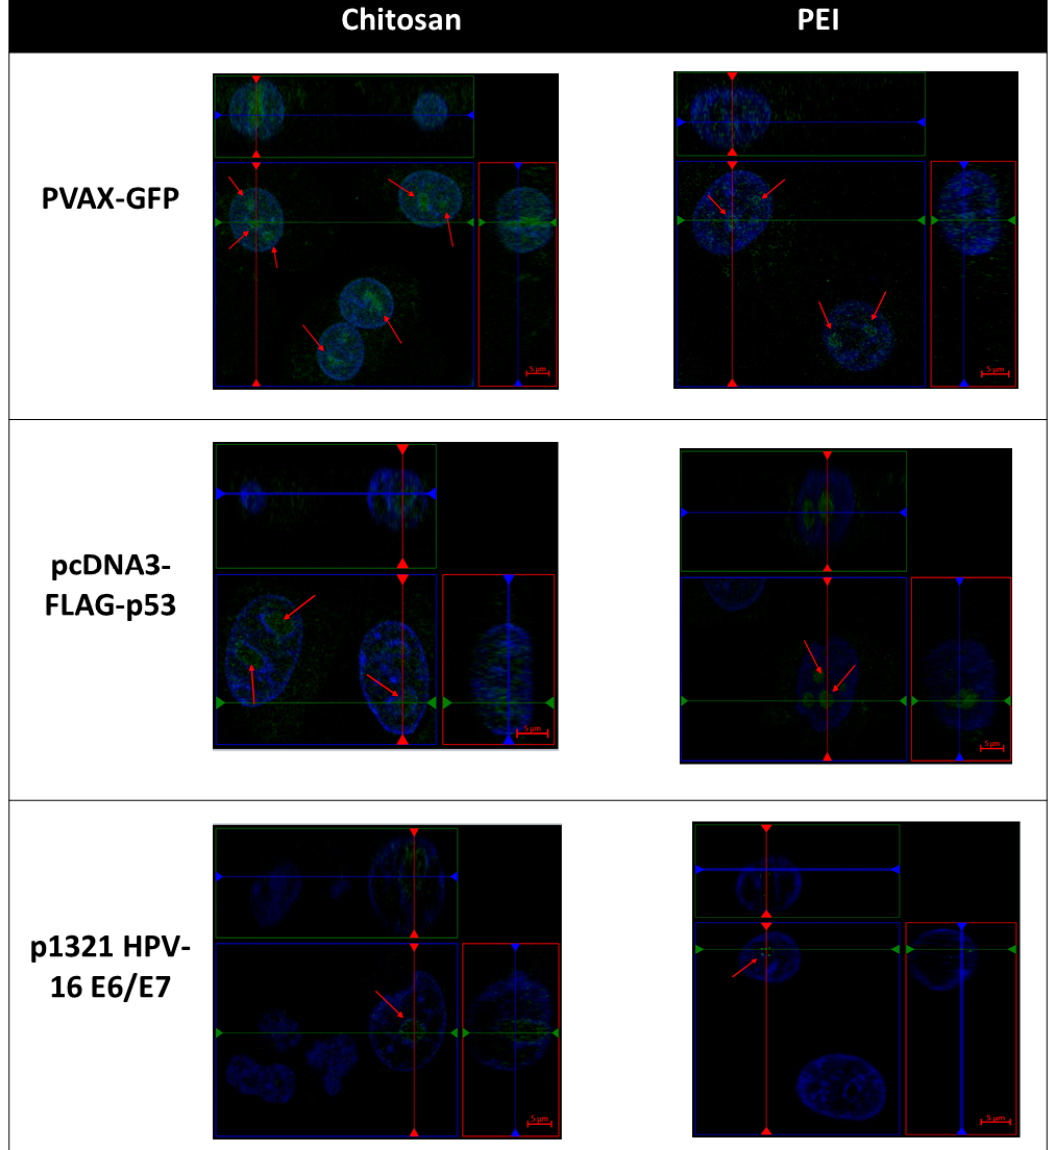
Figure 5. Orthogonal view of live cell imaging one hour after pDNA CH/PEI complexes addition to the HeLa cervix carcinoma cell line. The blue staining represents the nucleus of cells and the green staining represents FITC-labelled pDNA.